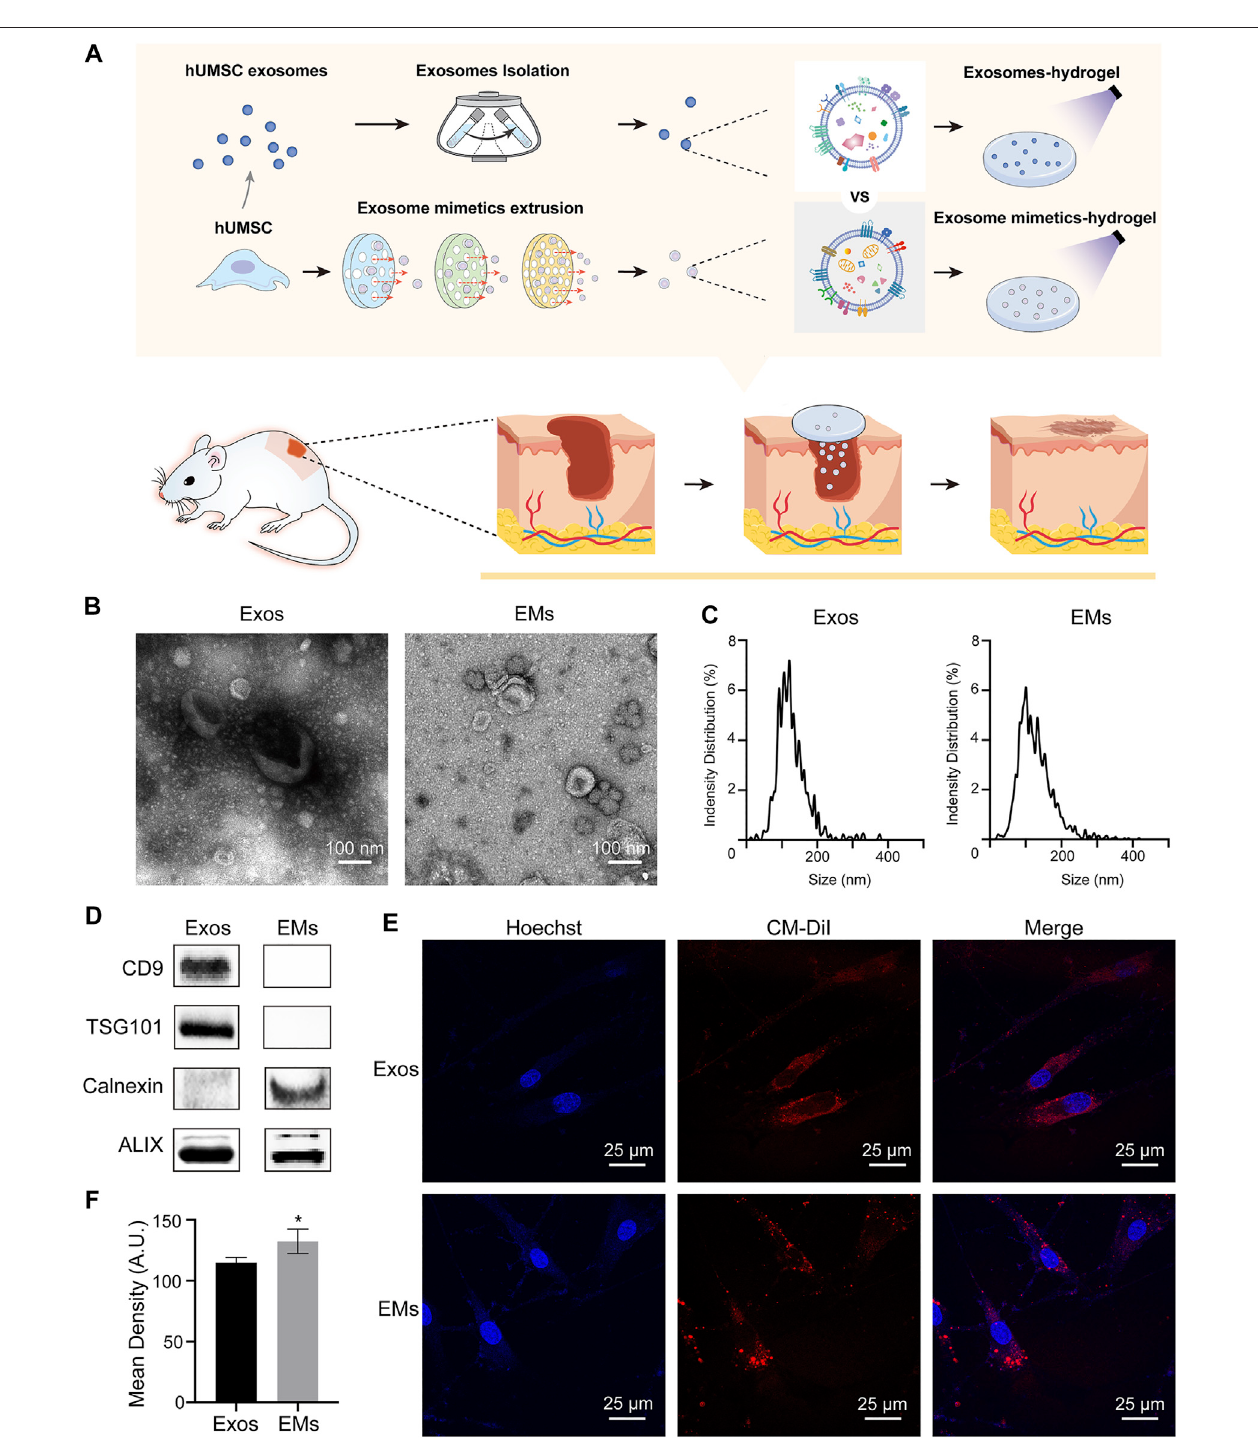
FIGURE 1 | (A) Schematic overview of the development of hUMSC-Exos and hUMSC-EM hydrogels for skin wound healing and tissue regeneration. (B) TEM imagesofhUMSC-derivedexosomesandexosomemimetics(hUMSC-derivedexosomes:Exos;hUMSC-derivedexosomemimetics:EMs). (C) Particlesizedistribution ofhUMSC-derivedexosomesandexosomemimeticsmeasuredbyusingnanoparticletrackinganalysis(NTA). (D) CharacteristicmarkersofhUMSC-derivedexosomes and exosome mimetics. Membrane surface marker proteins (CD9), exosome biogenesis marker proteins (TSG101), endoplasmic reticulum related protein (calnexin), and endoplasmic marker proteins (ALIX) were analyzed by Western blotting. (E) Internalization of exosomes and EMs by fi broblasts. Exosomes and EMs are labeled in red, and fi broblast nuclei are labeled in blue. (F) The quanti fi cation of internalization. ( n = 3, * p < 0.05)